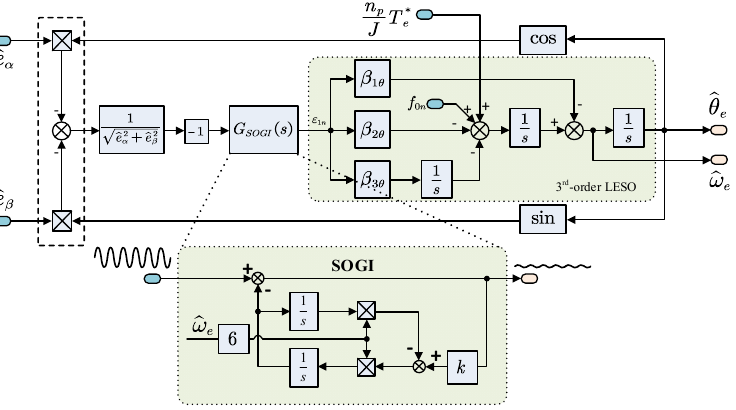
Figure 6. Block diagram of the enhanced LESO-based QPLL.